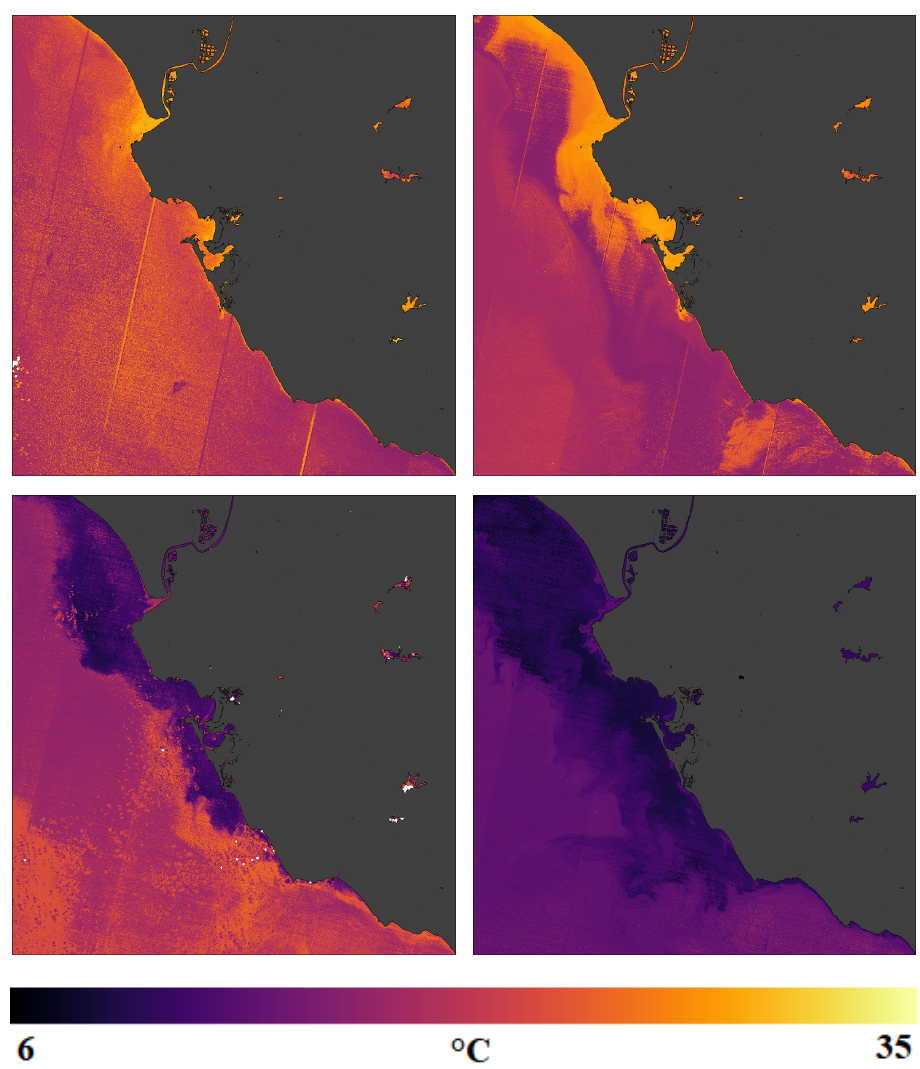
Figure 13. Evaluation of neural network: temperature prediction at the mouth of the Guadalquivir River during 2016 in May ( top left ), August ( top right ), October ( bottom left ) and December ( bottom right ). Units of temperature are ◦